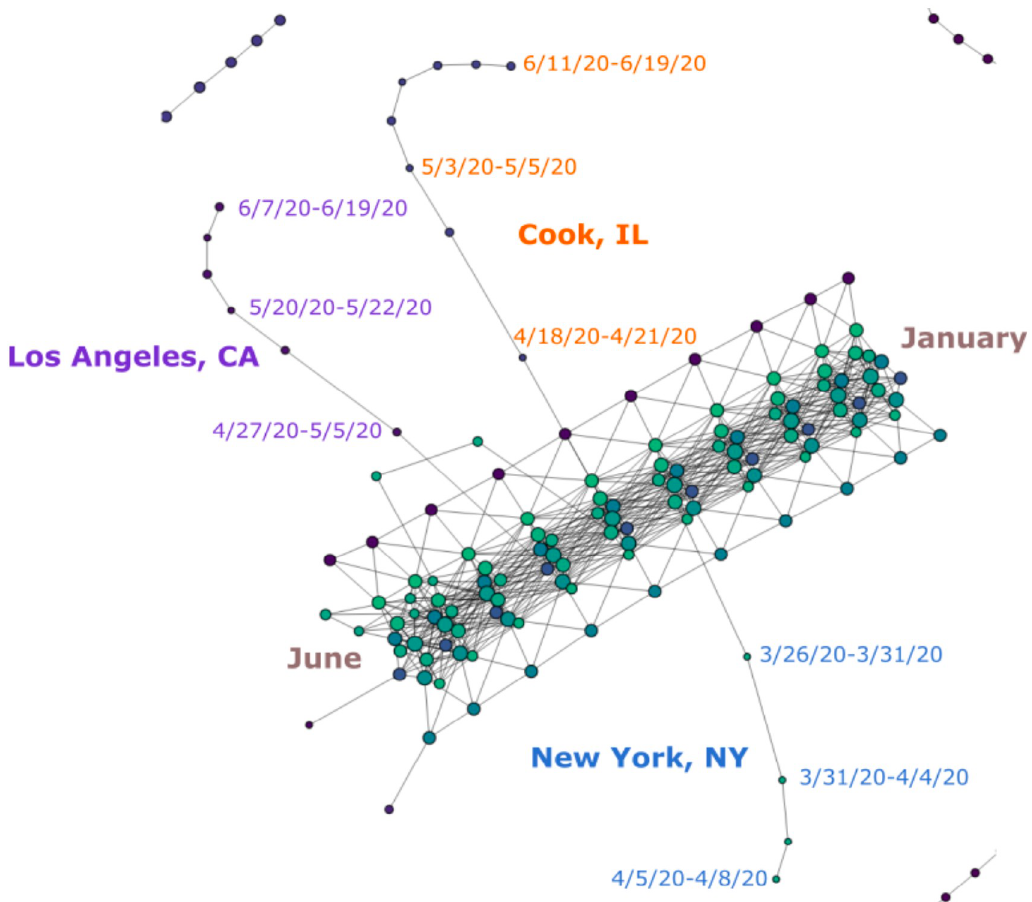
Fig 7. Main trunk and branches of Fig 2 showing time progression for unfiltered